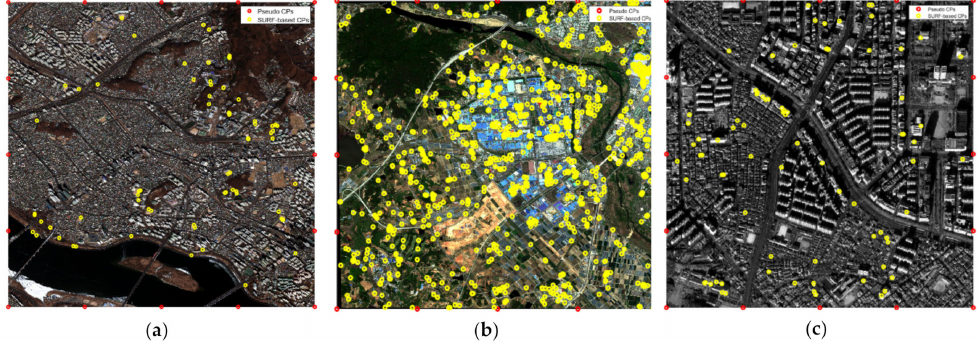
Figure 5. Extraction of conjugate points (CPs) from the real dataset: ( a ) First (Seoul), ( b ) second (Gwangju), and ( c ) third (Daejeon) sites. The yellow circles show speeded-up robust features (SURF)-based CPs, and the red circles show pseudo-CPs.